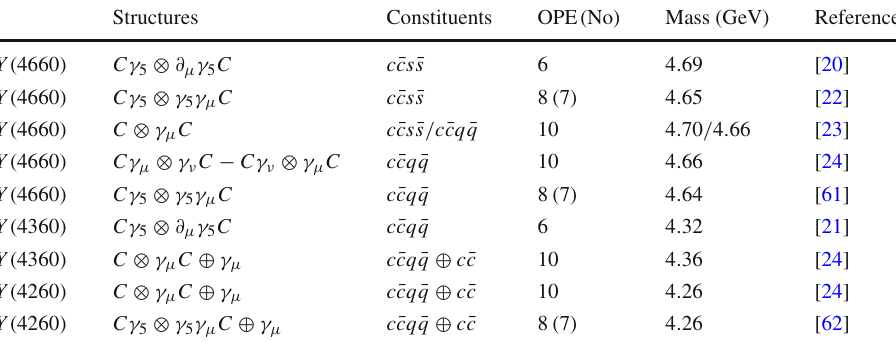
Structures Constituents OPE(No) Mass